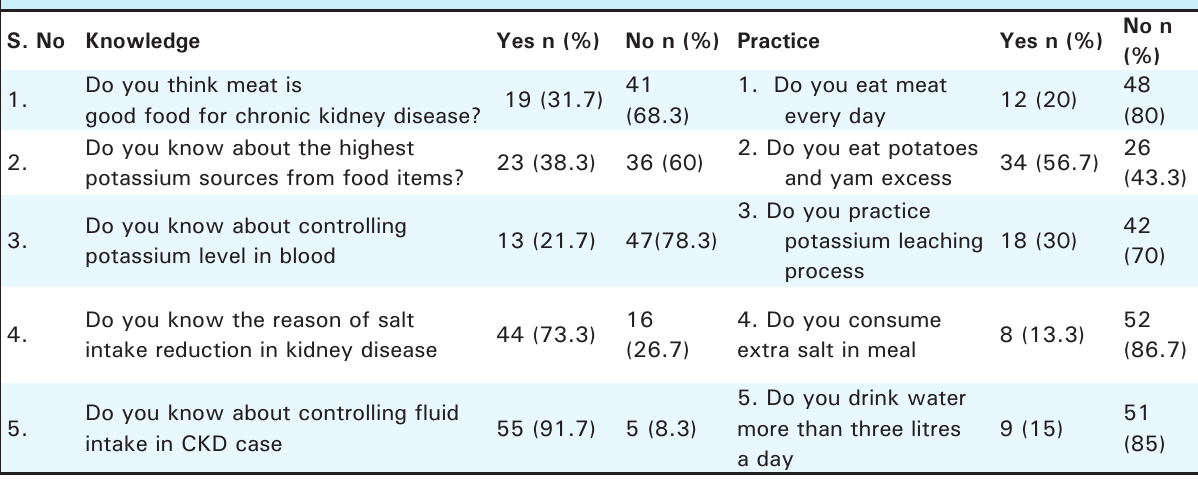
Table 4. Knowledge and practice